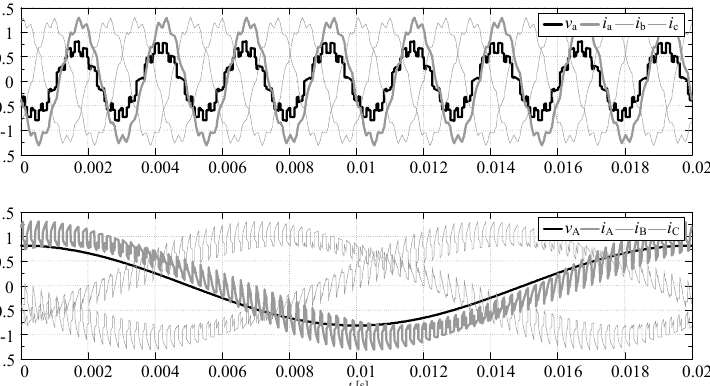
Figure 15. The waveforms of the phase voltages and currents at the output and input of the PWR controlled MMCCR for the S MC p switch state sequences: load model-1, q = 0.866, k f = 8.